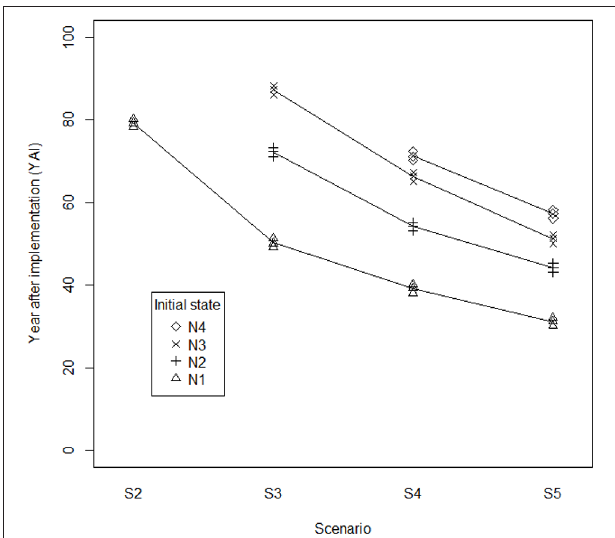
FIGURE 4 | Estimated number of years required for SWRT to cover 50% of the total area of coarse-textured soils for each scenario (S2, S3, S4, and S5) at different initial state levels (N1 = 1, N2 = 0.1, N3 = 0.05 and N4 = 0.01). Scenario S1 remained below 50% adoption regardless of the initial state.